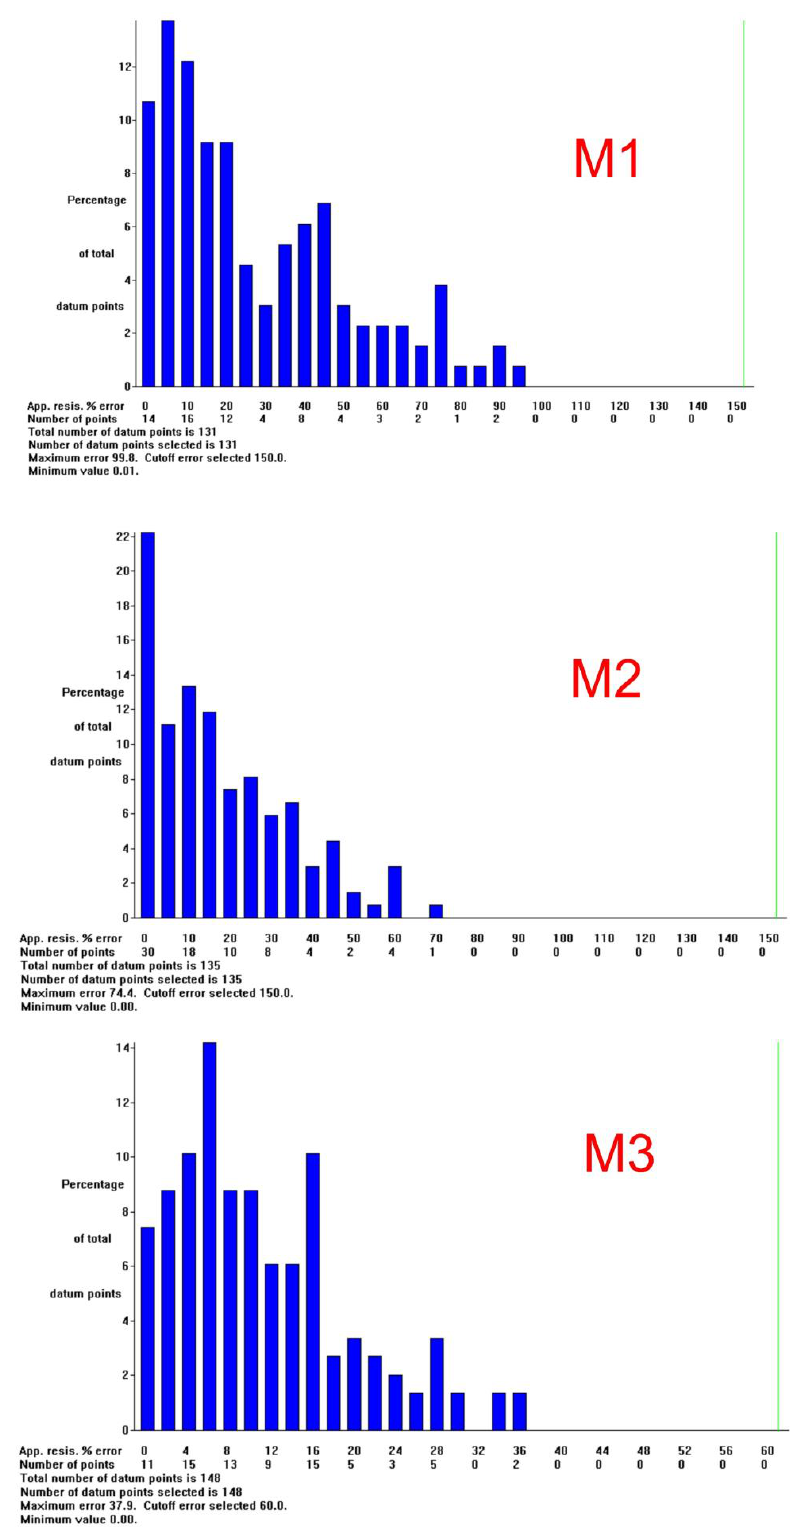
Figure 8. Bar chart of RMS (Root Mean Square) error statistics for the three